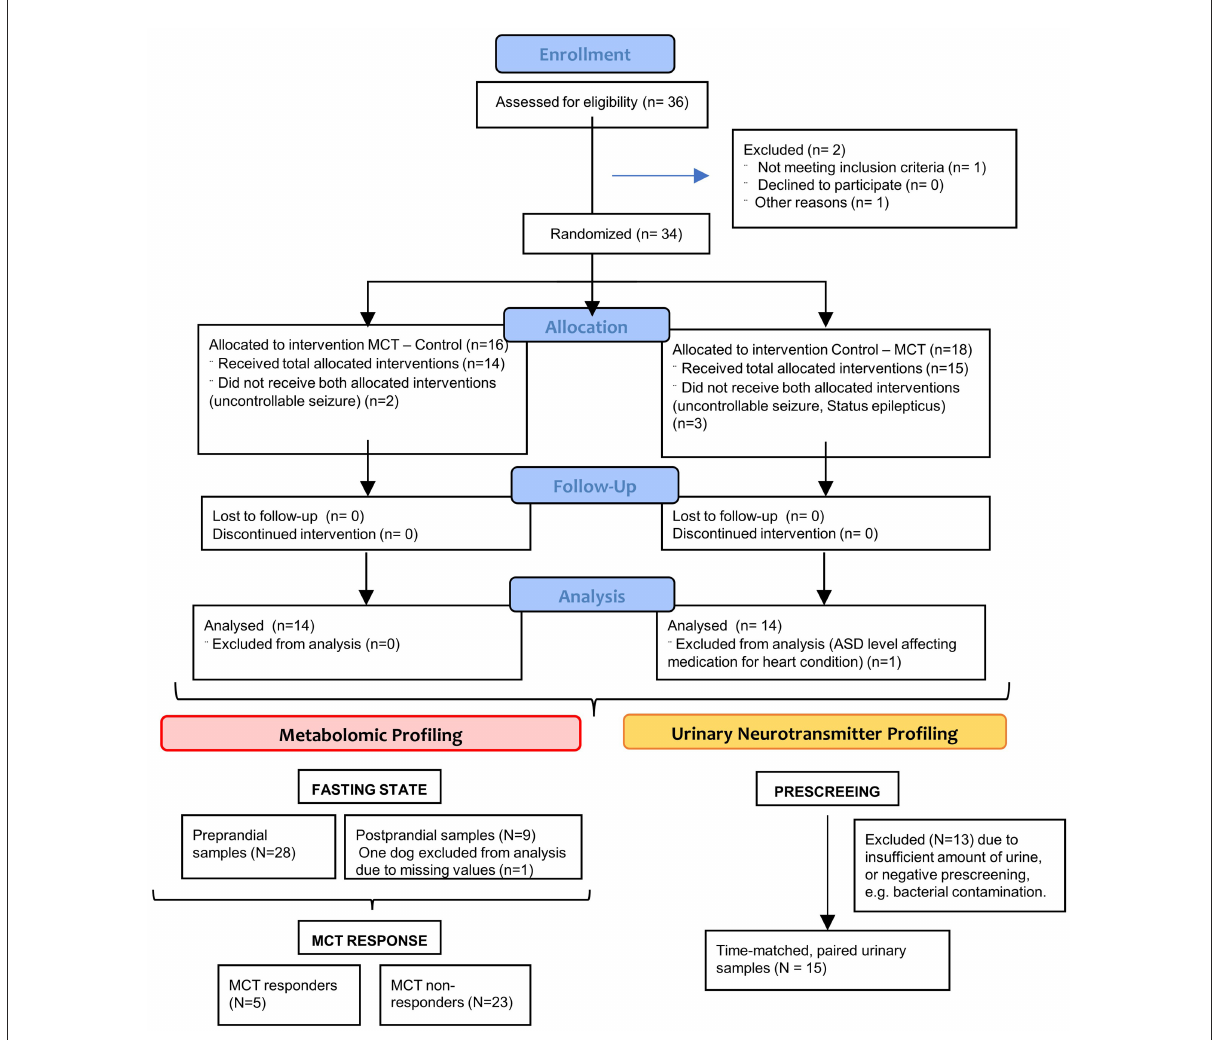
FIGURE1 CONSORT flow diagram—Flow diagram of the progress through the phases of this randomized clinical trial of two groups (that is, as shown, enrolment, intervention allocation, follow-up, and data analysis).